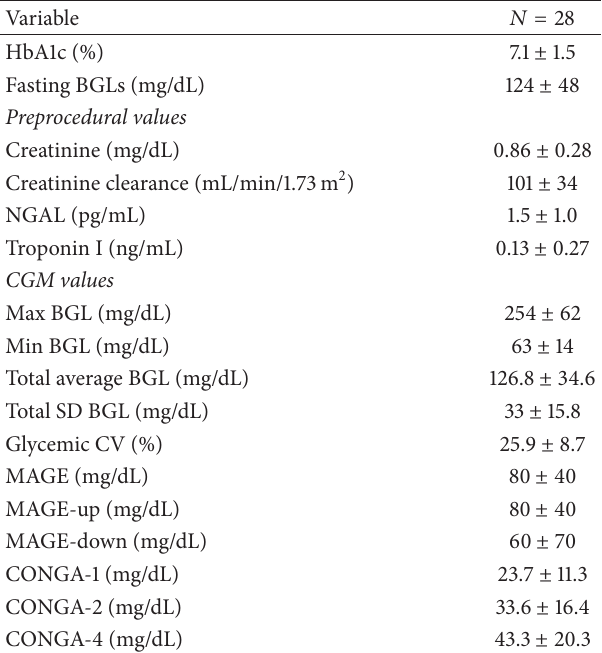
Table 4: Glycemic indexes and laboratory